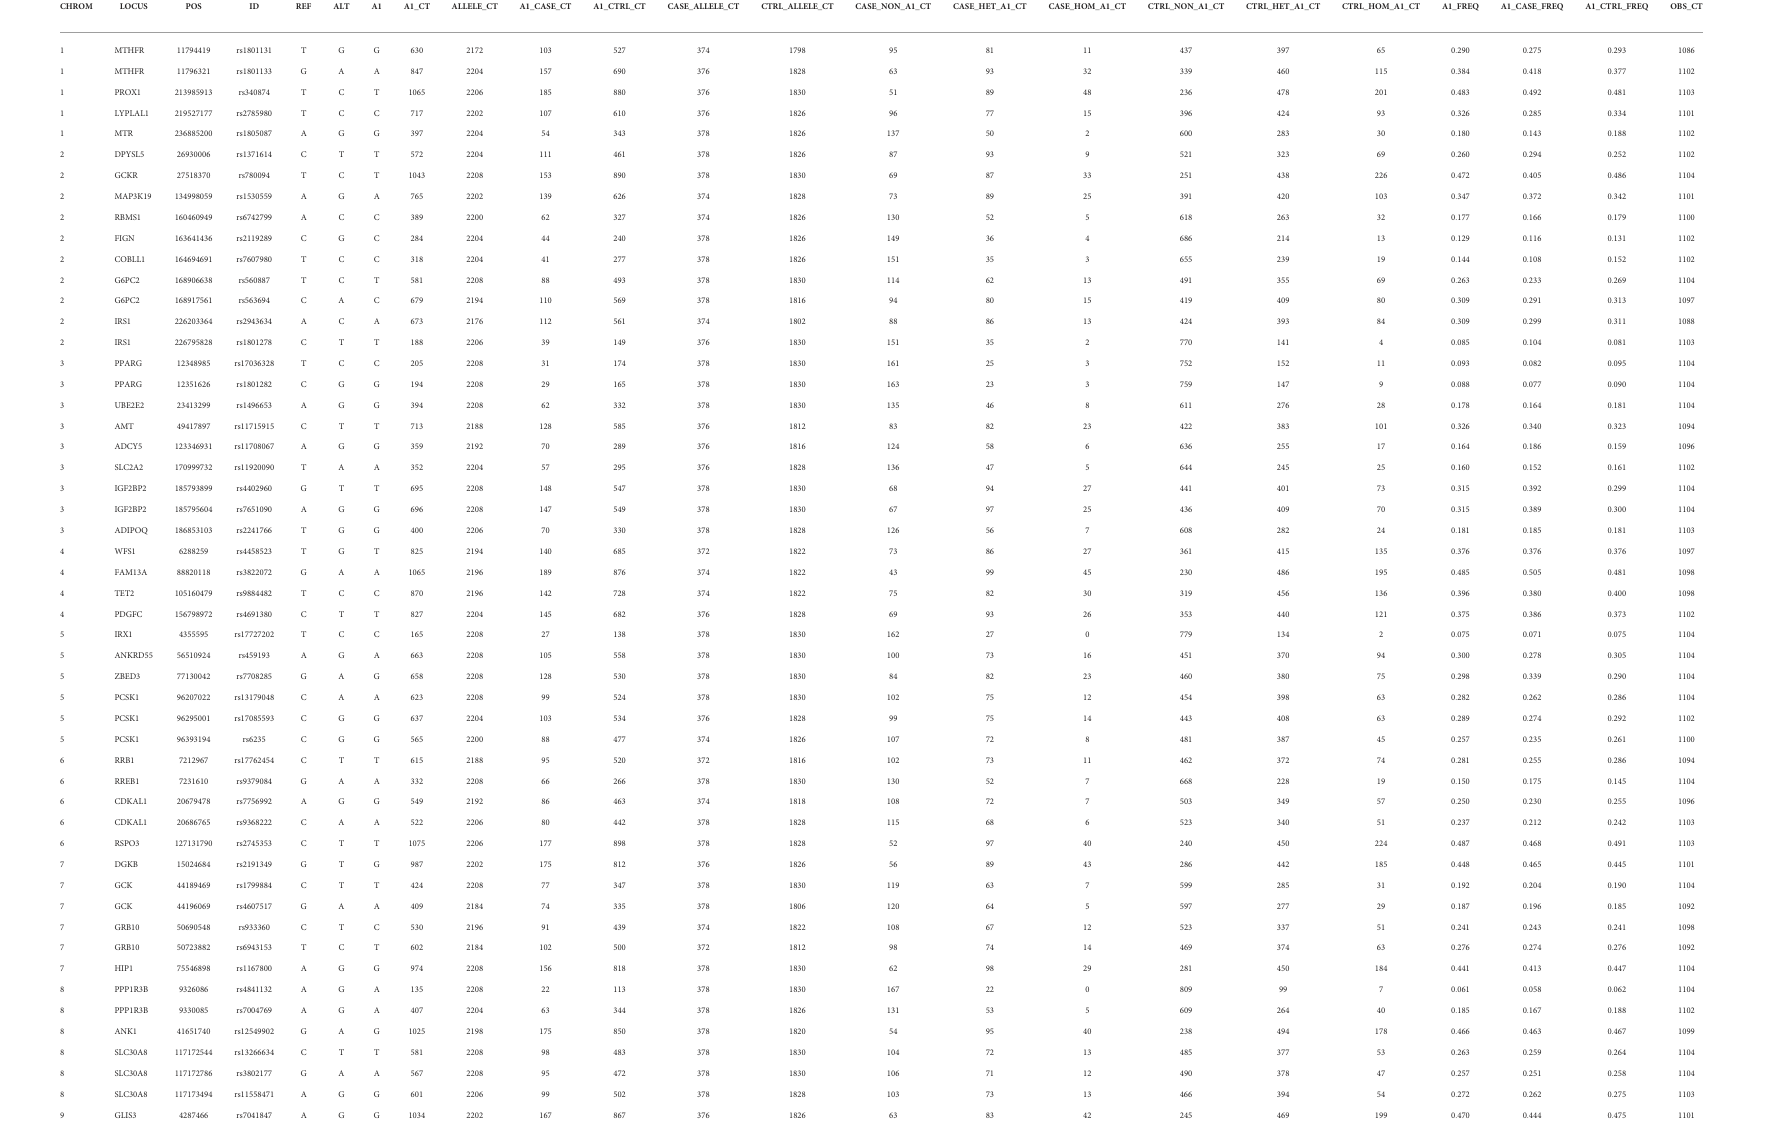
TABLE 2 CAU Characteristics of variants.